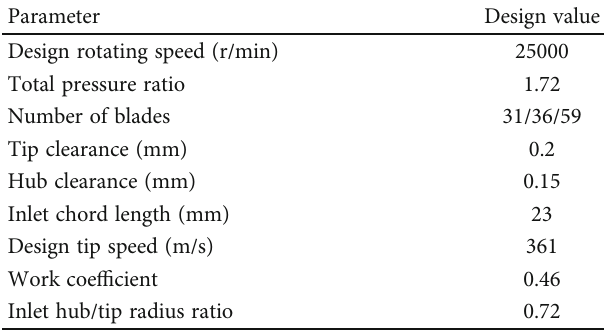
Table 1: Parameters of the 1.5-stage